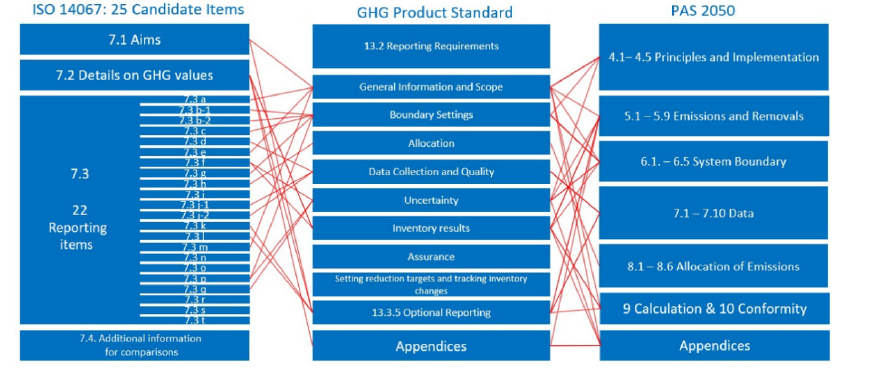
Figure 1. Consolidation of transparency catalogue. Table 1. Methodological items of carbon footprint